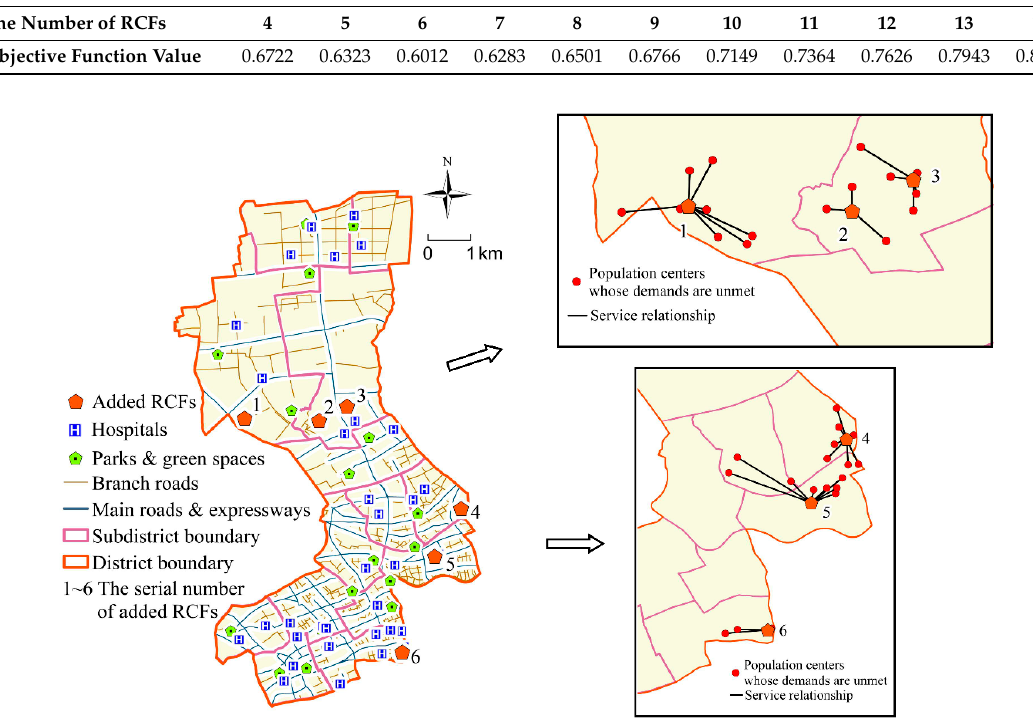
Figure 5. The locations of newly-added RCFs and their service relationship with population centers.